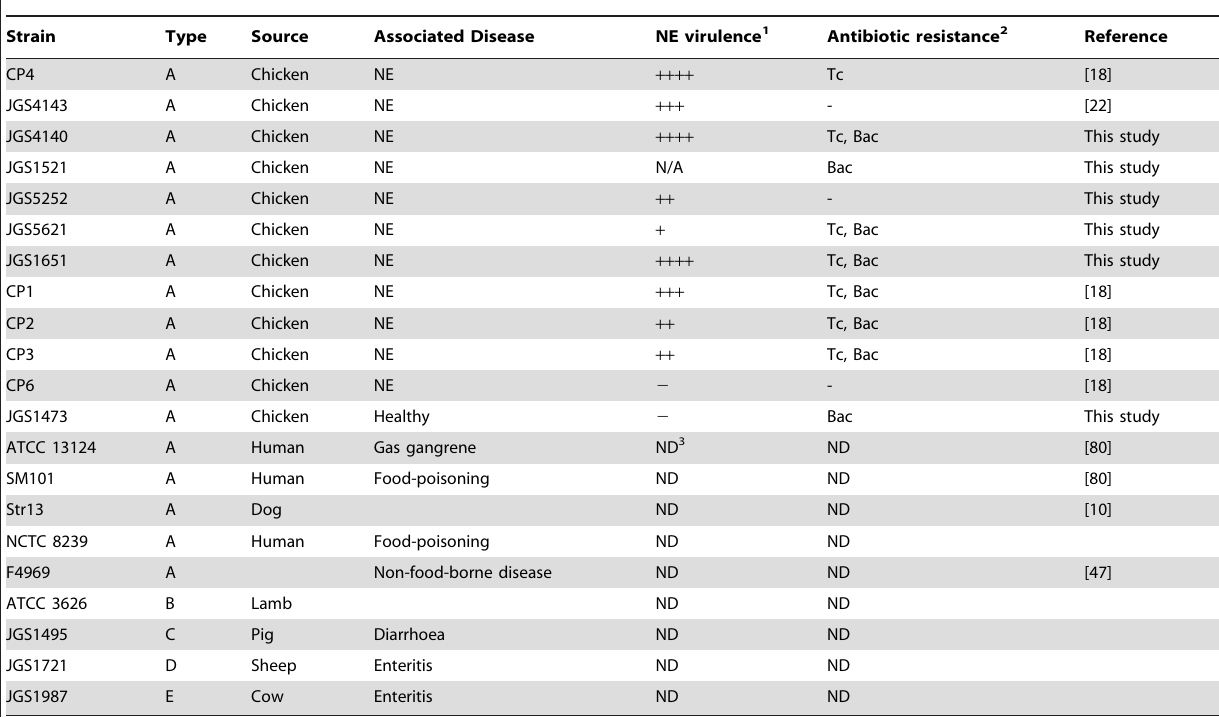
Table 1. List of Clostridium perfringens strains used in this